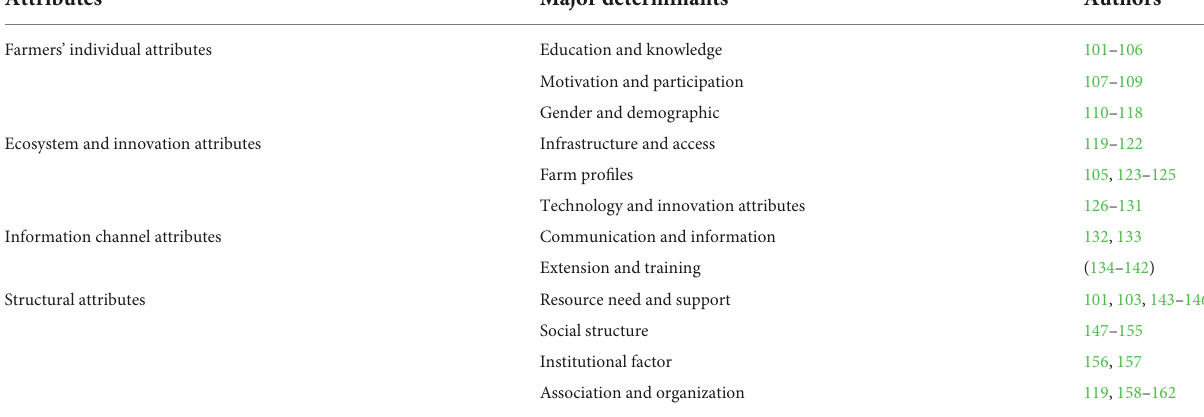
TABLE 5 Attributes, main determinants and list of reported studies – rice.